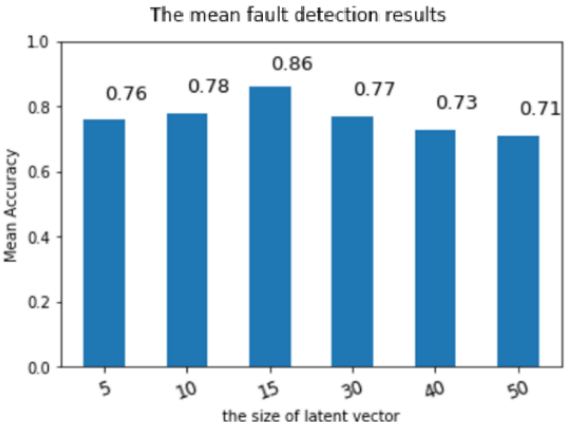
Figure 7. The mean fault detection results w.r.t. varying values of the latent vector